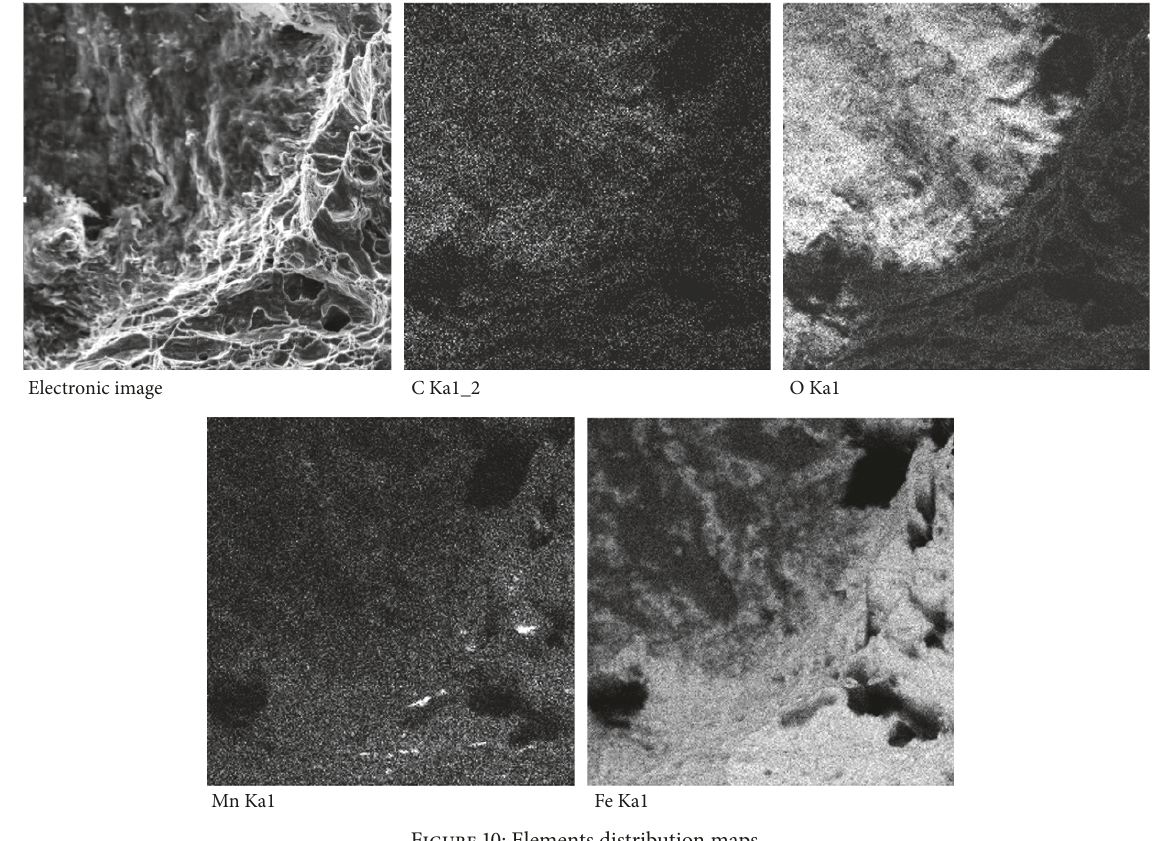
Figure 10: Elements distribution maps.